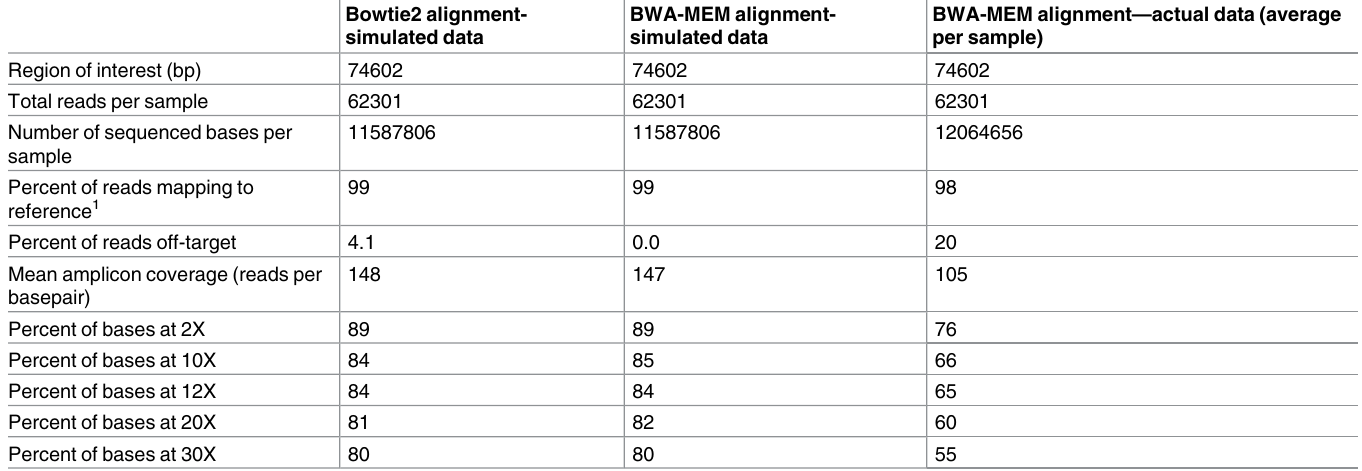
Table 2. Simulations and alignments. The first two columns show the alignmentstatistics for the Bowtie2and BWA-MEM alignments of the simulated data. The third column shows the alignment statistics for the actual data. For the actual data, the alignment statistics were averagedacross all samplesso that the per sample averageis shown in the